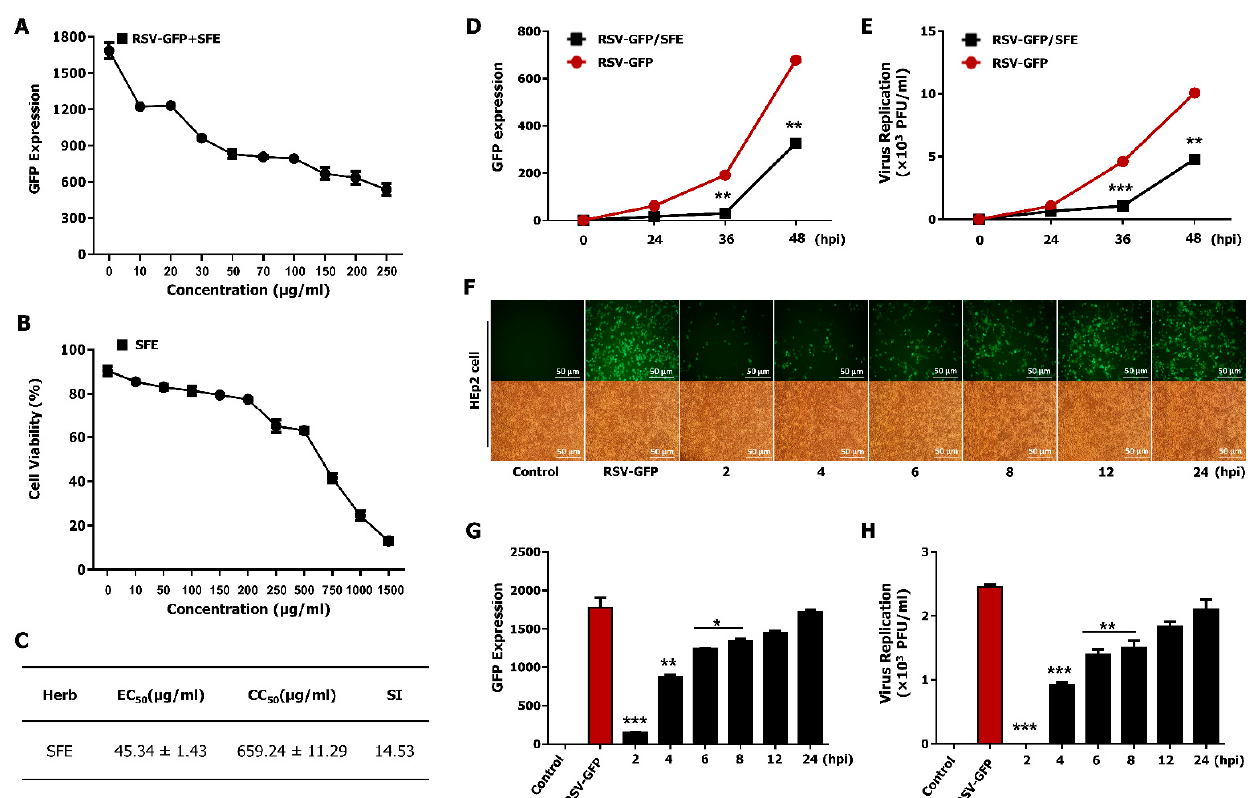
Figure 2. The therapeutic effect of SFE against RSV–GFP infection. ( A ) A monolayer of HEp2 cells in a 12 well plate was infected with RSV–GFP (0.1MOI) for 2 h, and the medium was changed into 10% FBS containing DMEM with indicated concentrations of SEF and GFP expression levels were measured at 48 hpi. ( B ) The viability of HEp2 cell upon SFE treatment with indicated concentrations was measured at 48 hpi. ( C )The ratio between CC 50 and EC 50 was considered as selectivity index (SI). A monolayer of HEp2 cells cultured in a 12-well plate was infected with RSV–GFP (0.1MOI) for 2 h. ( D ) GFP expression levels at different time points after 50 µ g/mL SFE treatment, and ( E ) viral load in the cells and cell supernatant was measured by standard plaque assay, ( F – H ) 50 µ g/mL SFE treatment to the infected cells was performed at indicated time points following virus infection. ( F ) GFP expression images. ( G ) GFP expression levels. ( H ) Virus titer from both cells and cell supernatant were taken at 48 hpi. Scale bar-50 µ M. GFP absorbance and virus titer expressed as mean ± SD. Data are representative of three independent experiments, each with similar results (* p < 0.05, ** p < 0.01 and *** p < 0.001 regarded as significant difference).